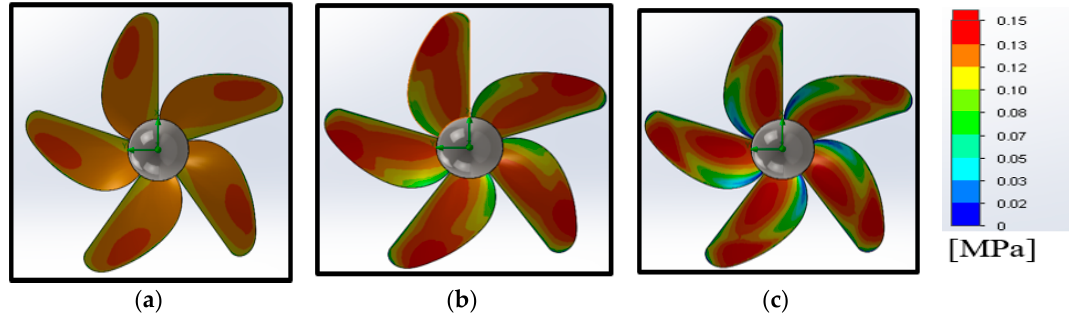
Figure 11. Contour of pressure on the blade pressure side for various TSR : ( a ) TSR = 1.0; ( b ) TSR = 2.5; ( c ) TSR = 4.0.